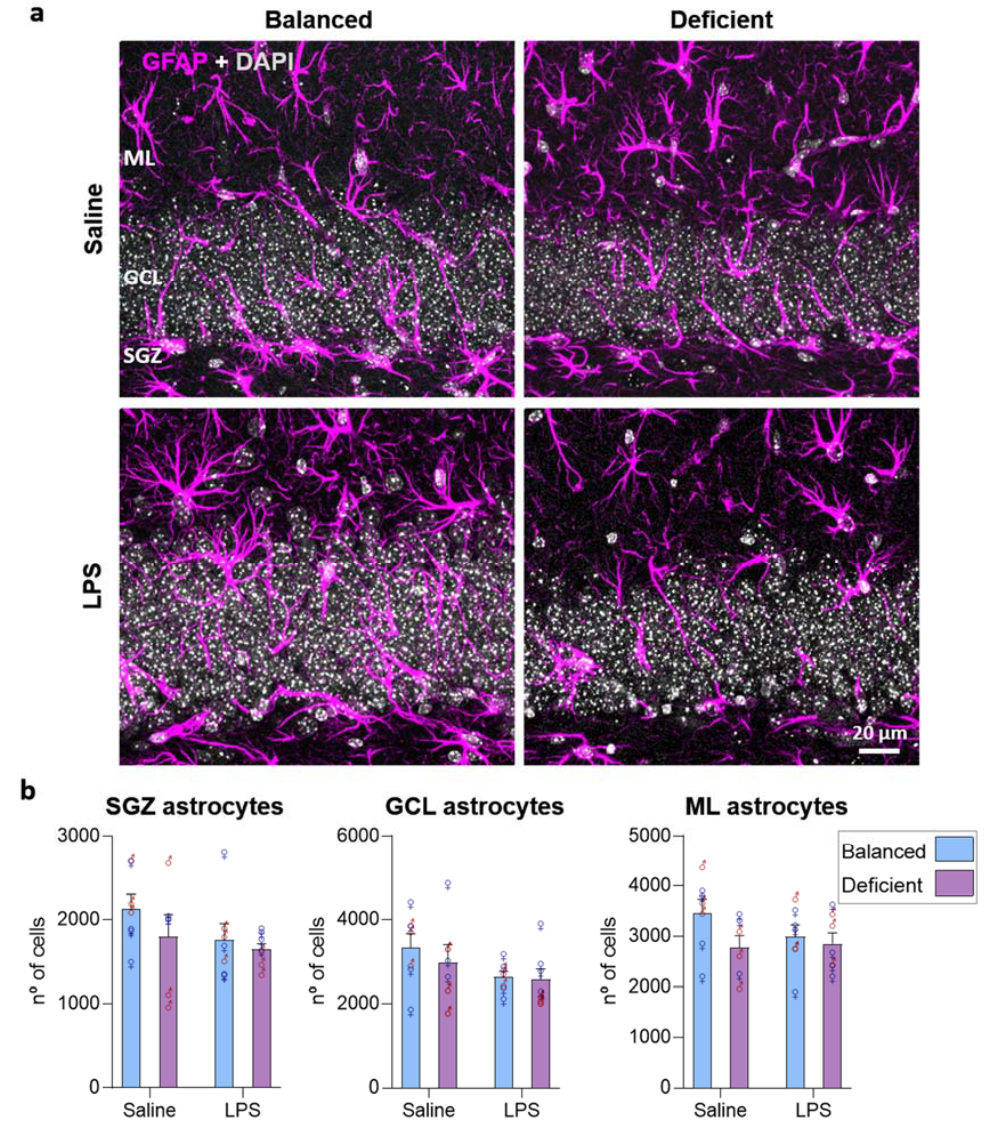
Figure 8. The n-3 PUFA-deficient diet had no relevant effects on astrocyte number. ( a ) Confocal images (maximum intensity projection, z = 13.8 μ m) of the dentate gyrus of the hippocampus showing glial fibrillary acidic protein (GFAP, magenta) expression and DAPI staining (white) in the subgranular zone (SGZ), granular cell layer (GCL), and molecular layer (ML). ( b ) We did not detect consistent significant differences in the number of astrocytes between the different groups of mice analyzed (statistics detailed in Supplementary Data).